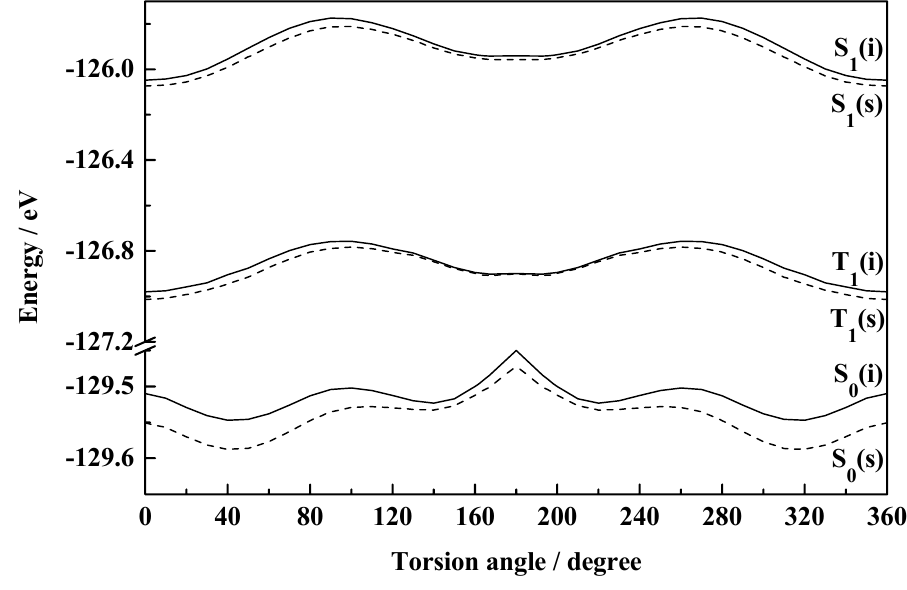
Figure 2. Plot of total molecular energy as a function of torsional angle (7-8-10-11) in S states of HBI (i, isolated; s, solvated in